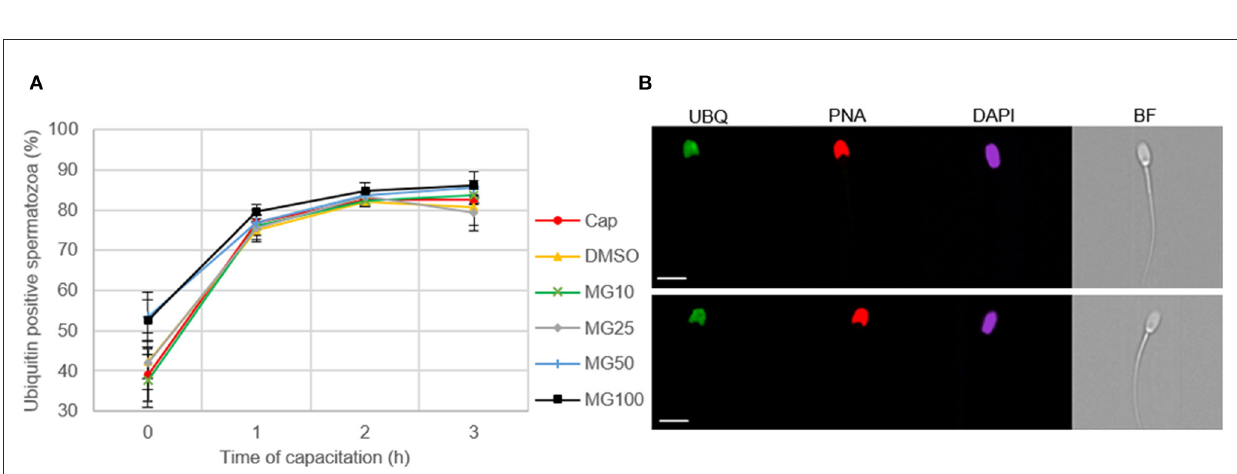
FIGURE6 Assessment of sperm ubiquitination during sperm in vitro capacitation (IVC) under proteasome inhibiting conditions at various concentrations of MG-132 (10, 25, 50, and 100 µ M) including capacitating (Cap) and vehicle (DMSO) controls. (A) Quantification of the ubiquitin-positive spermatozoa in individual treatment groups during sperm IVC. (B) Representative IBFC images of ubiquitin immunolabeling (UBQ) in the sperm head with antibody, acrosome status with PNA lectin and DAPI staining of the sperm nuclei; scale bar 10 µ m. The images are representative of all groups. Data are presented as mean ± SEM. No significant differences were observed; n =